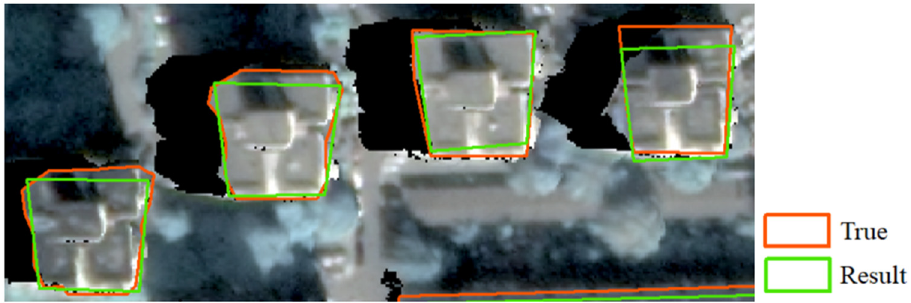
Figure 13. The buildings with ∆ θ > 3 ◦ in Beijing region.